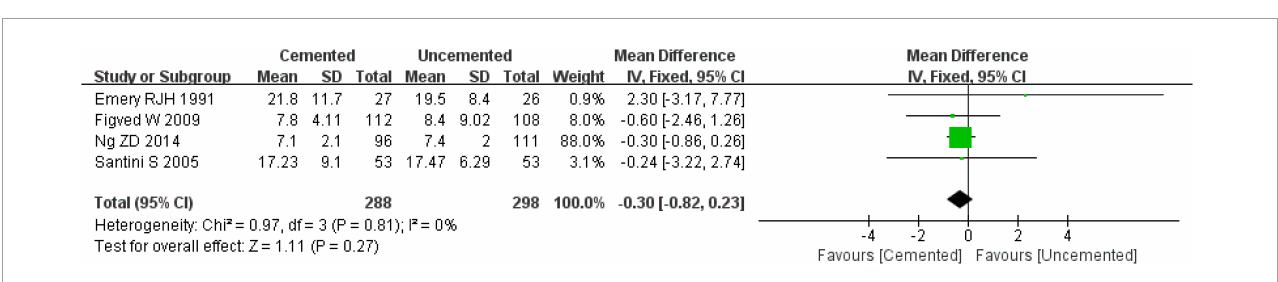
FIGURE6 Forest plot for comparison of length of hospital stay between the cemented bipolar hemiarthroplasty (CBH) and uncemented bipolar hemiarthroplasty (UCBH)